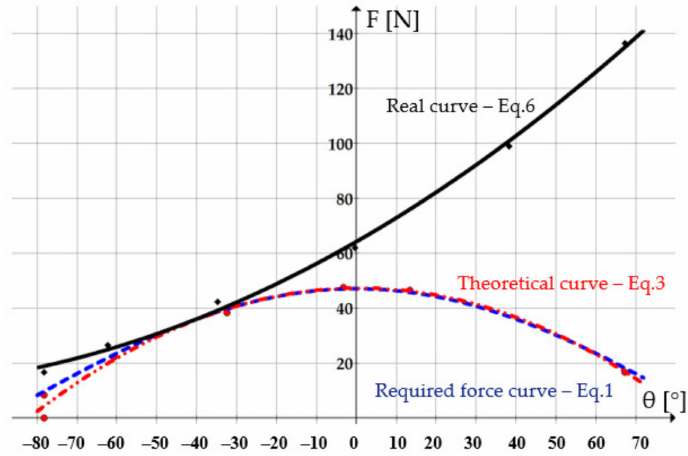
Figure 11. Variation of the force developed by the pneumatic muscle versus the flexion/extension angle of the wrist.